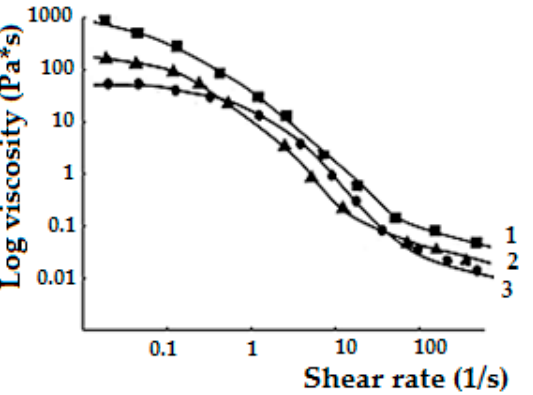
Figure 5. Viscosity as a function of shear rate for hydrogels: 1—chitosan hydrochloride/citrus pectin, T = 20 ◦ C; 2—chitosan hydrochloride/apple pectin, T = 20 ◦ C; 3—chitosan hydrochloride/apple pectin, T = 40 ◦ C. Data are expressed as mean ± SD; n = 3.